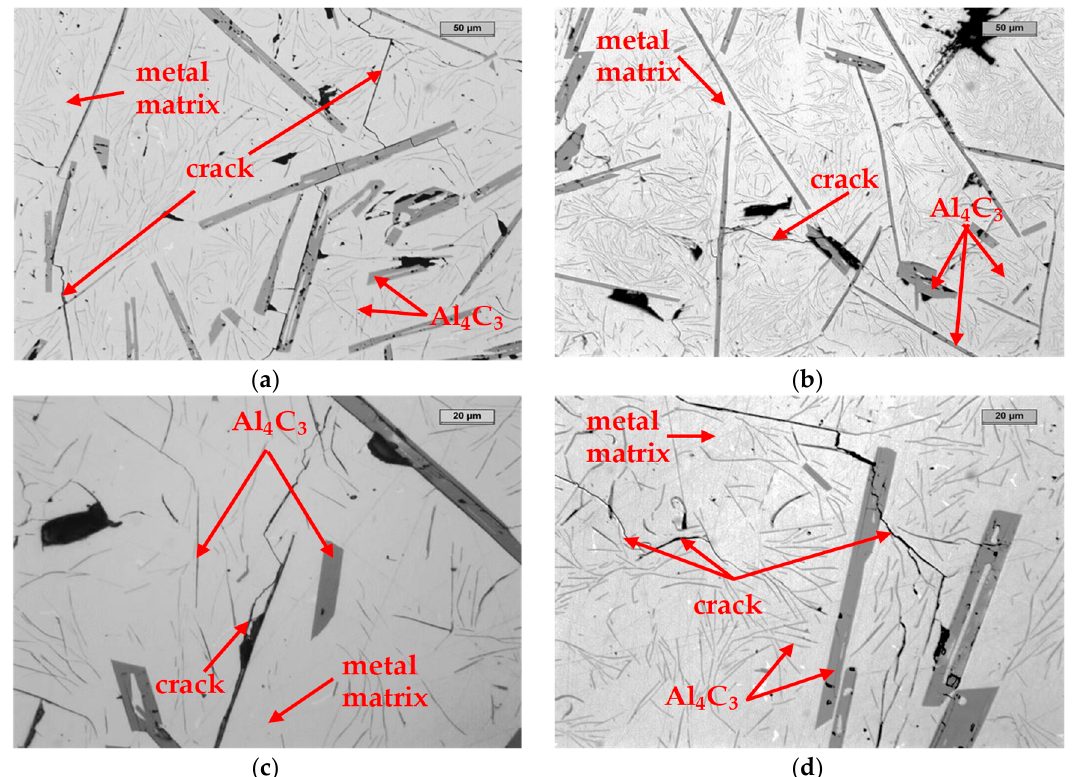
Figure 8. Microstructure of specimens of a high-aluminum cast iron with visible fractures of the metal matrix. Photos ( a – d ) present the structure of reference samples from high-aluminum cast iron, which were subjected to the phenomenon of spontaneous decomposition.